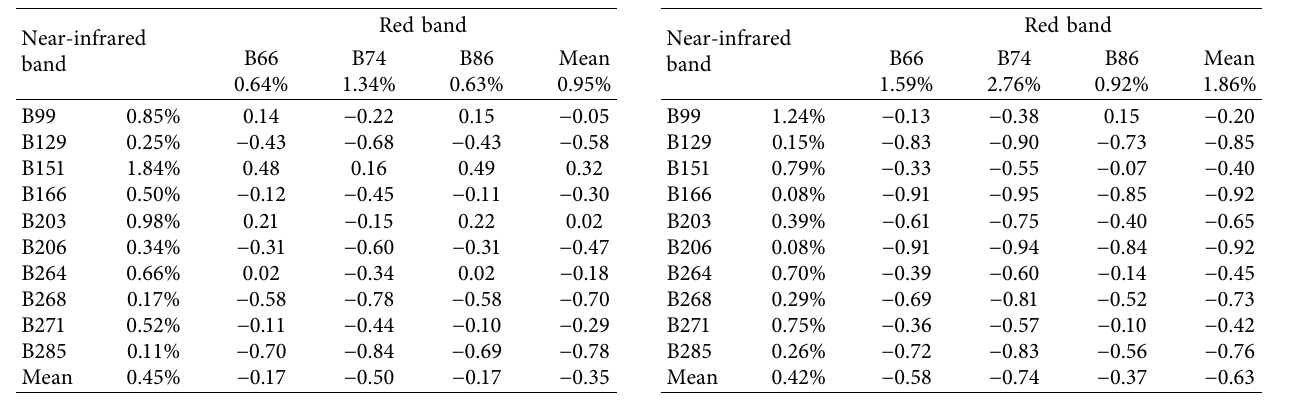
Table 5: NDVI values of characteristic bands in